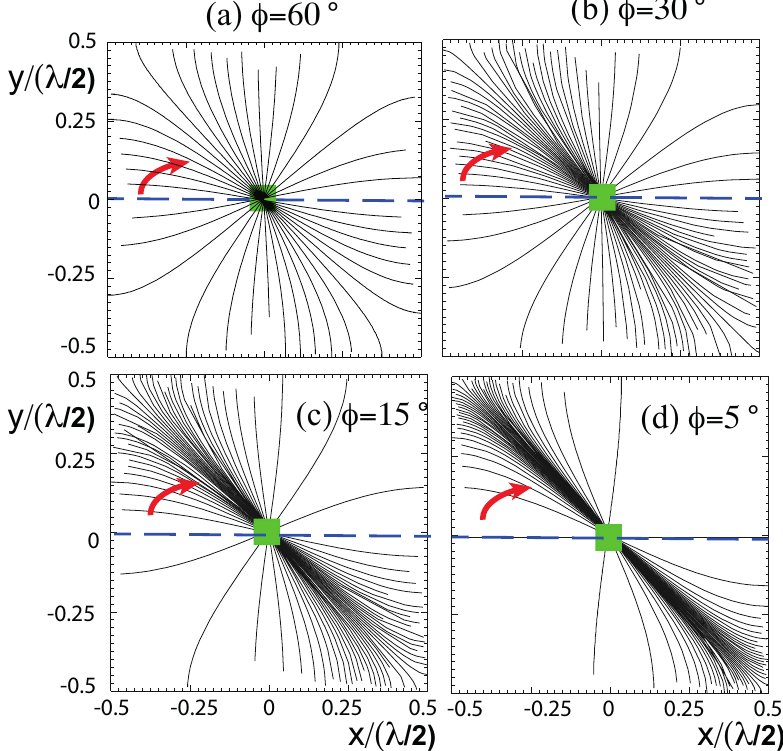
Figure 4. Rotation of the z = 0 isoline of the surface elevation followed over half a wave period T /2. The blue line marks t = t 0 . The red arrow points in the direction of the rotation. ( a ) φ = 60 ◦ , ( b ) φ = 30 ◦ , ( c ) φ = 15 ◦ , and ( d ) φ = 5 ◦